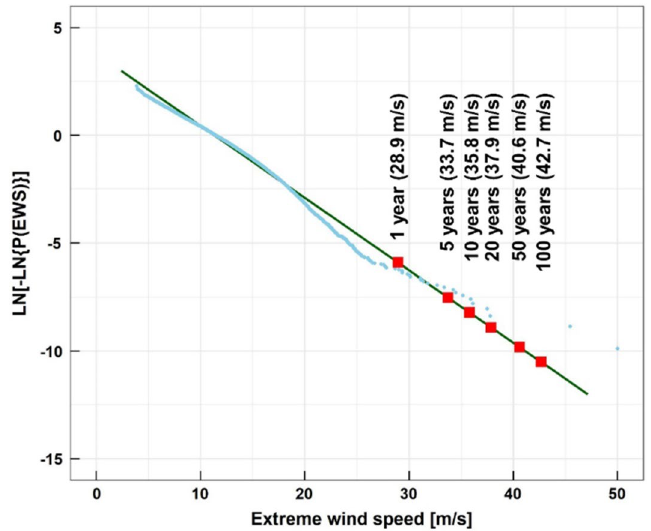
Figure 11. Estimation of extreme wind speeds with Gumbel distribution fitted at 100.5 m.